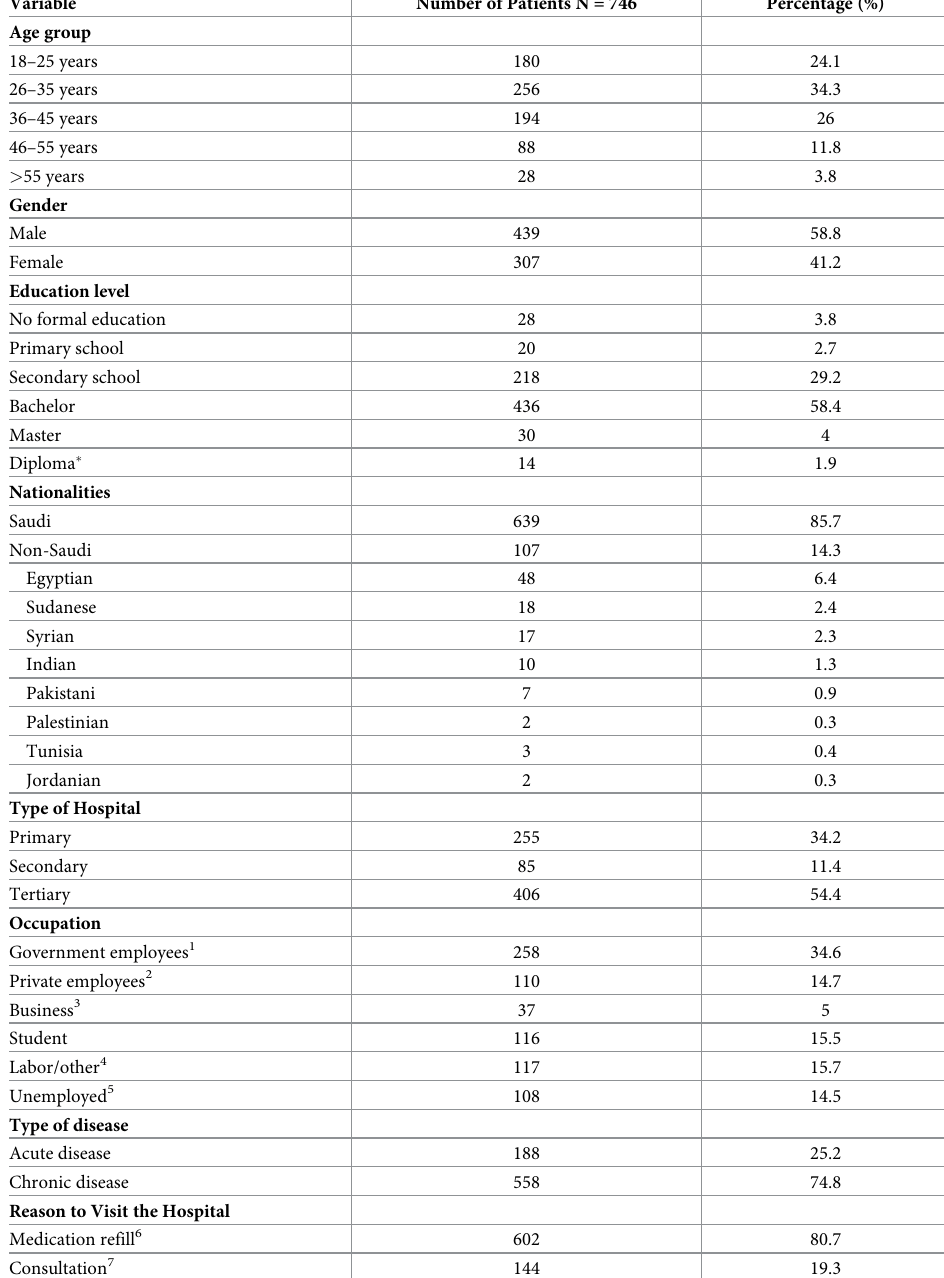
Table 1. Socio-demographic characteristics of study